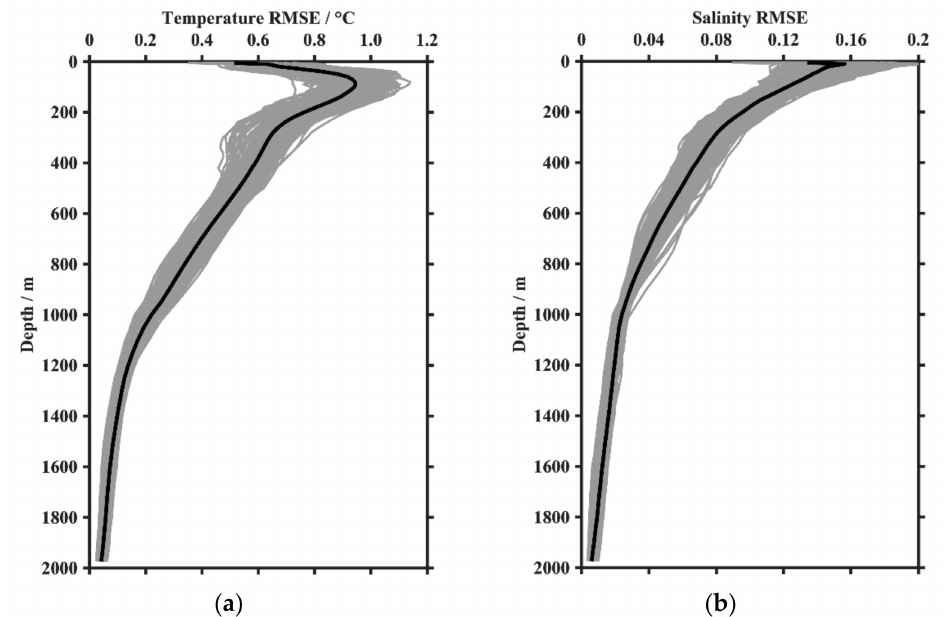
Figure 4. Vertical distributions of the RMSEs of ( a ) temperature and ( b ) salinity between the gridded GDCSM-Argo analysis and merged observations at a depth of 0–2000 m over 204 months. The thick black lines represent average values of the RMSE for each variable while the thin gray lines show the monthly